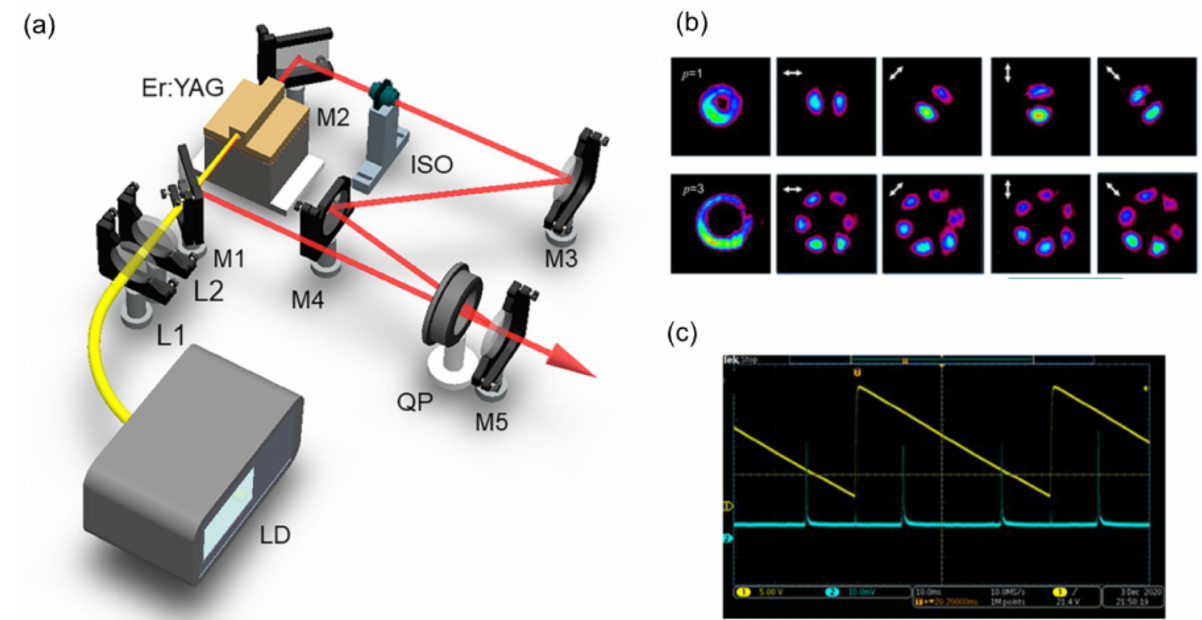
Figure 6. Simultaneous tailoring longitudinal and transverse mode inside an Er:YAG laser. ( a ) Schematic diagram of the laser; ( b ) Experimentally obtained intensity profiles of vectorial vortex beams when inserting q-plates with q = 1/2 (first row) and q = 3/2 (second row) in unidirectional operation before and after passing through a polarizer; ( c ) Scanning spectrum of the output single- longitudinal-mode 3rd order vectorial vortex beams in unidirectional operation. Reprinted with permission from [123] © 2021 Chinese Optics